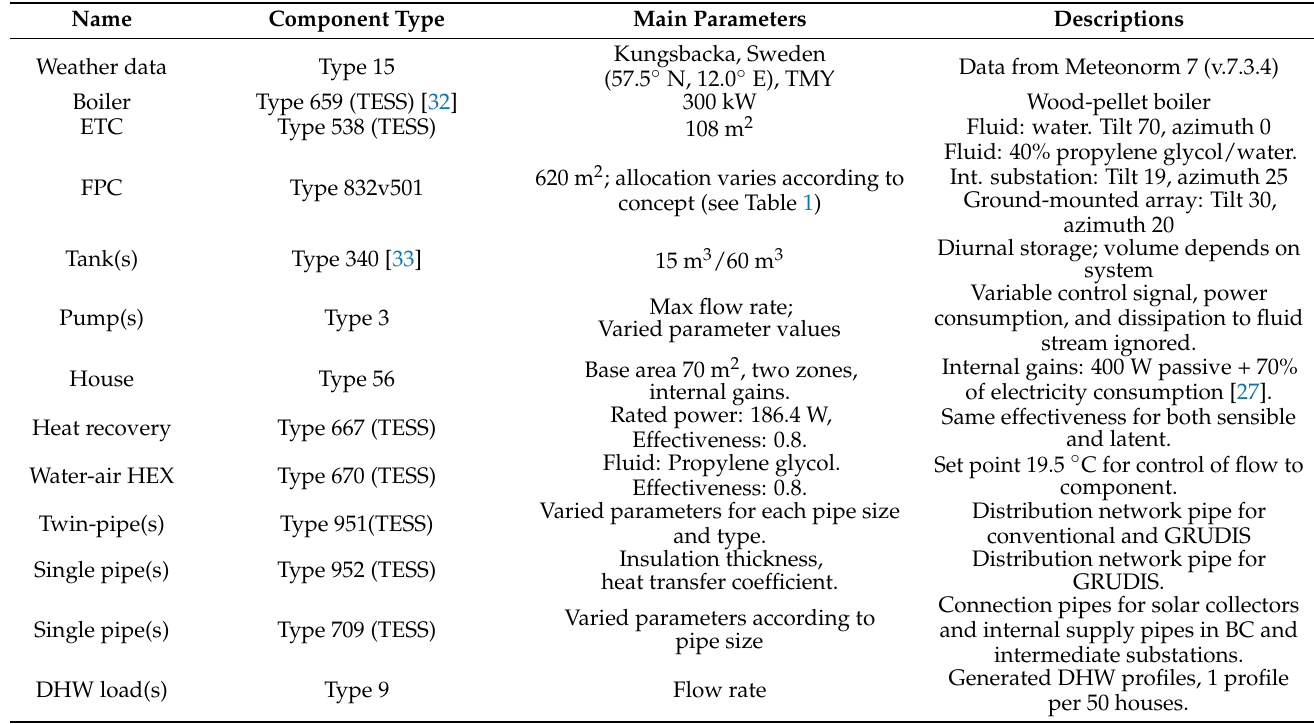
Table 3. Main TRNSYS components and parameter settings [31]. Non-standard components are referenced individually, TESS components are described in [32]. Data from